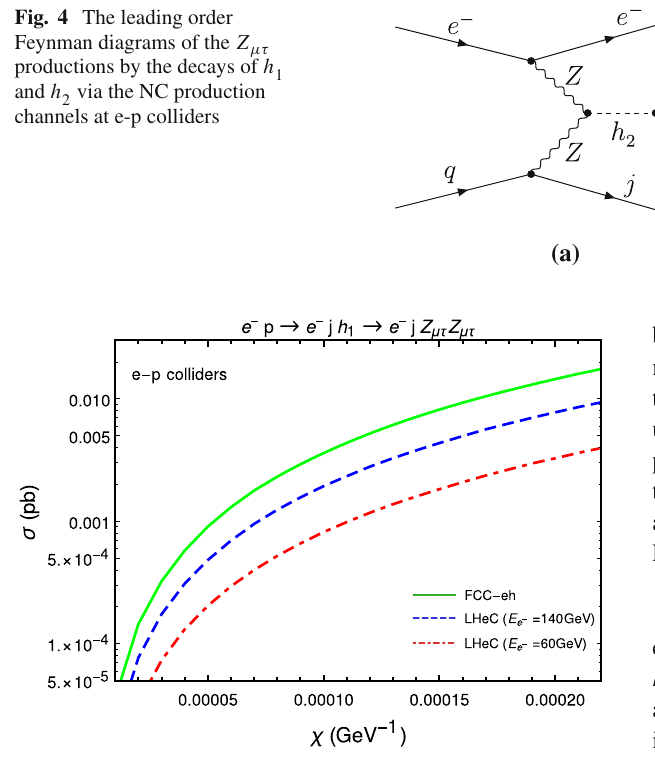
Fig. 5 The production cross sections of the process e − p → e − jh 1 → e − jZ μτ Z μτ as functions of χ at e-p colliders